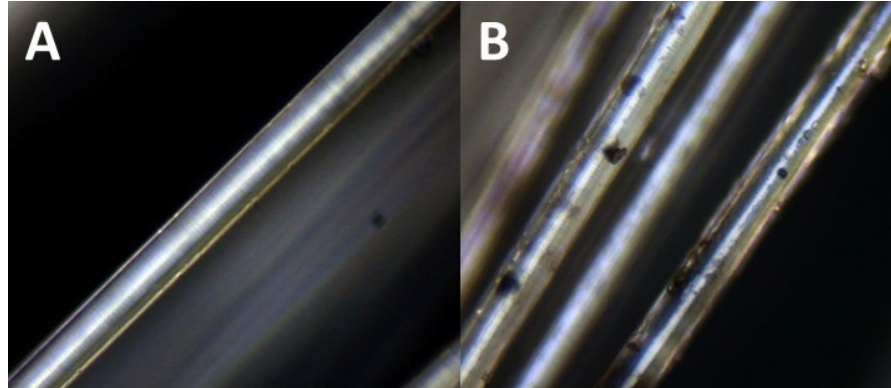
Figure 7: Microscope images of (A) AFs and (B) GO-AFs